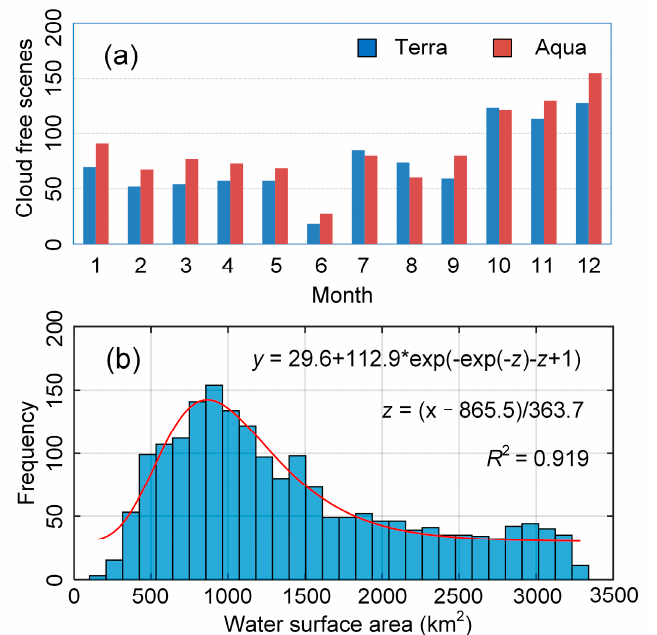
Figure 14. Frequency distribution of cloud free Terra and Aqua MODIS images ( a ), and the distribution of water surface area data derived from cloud free MODIS images (b).